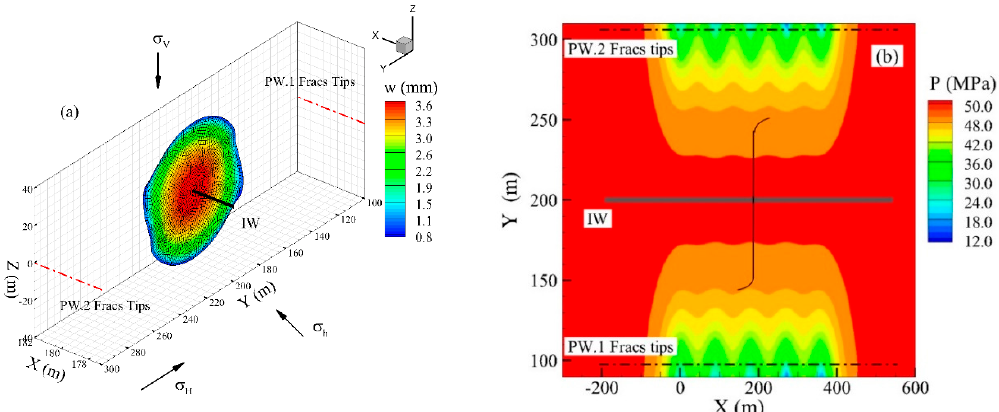
Figure 20. Infill well fracture propagation before repressurization of the production well fractures in the normal faulting stress regime after 1.5 years of production: ( a ) generated fracture geometry, ( b ) plan-view of the propagated fracture geometry on top of the reservoir pore pressure plot.